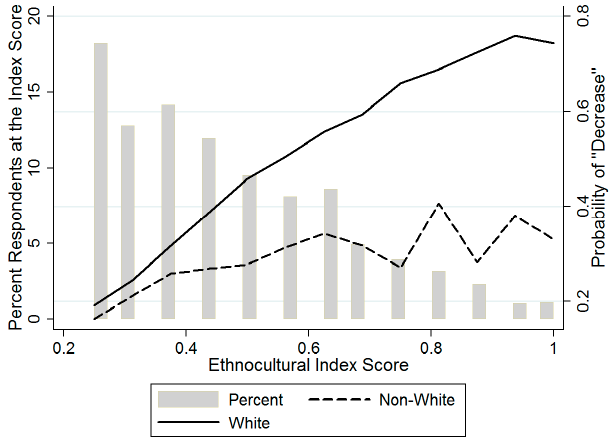
Figure 8. Predicted probability of “decrease” response by race and ethnocultural index score.